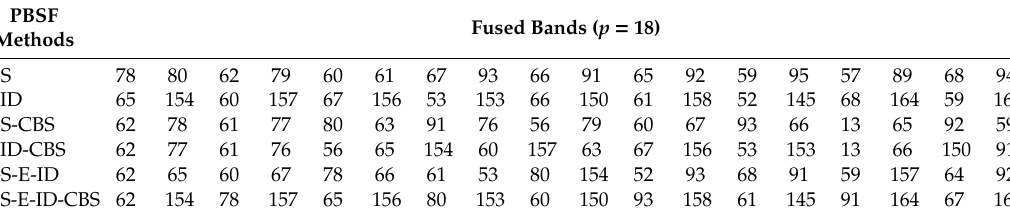
Table 3. The 18 bands selected by various progressive band selection fusion (PBSF) methods. PBSF Methods